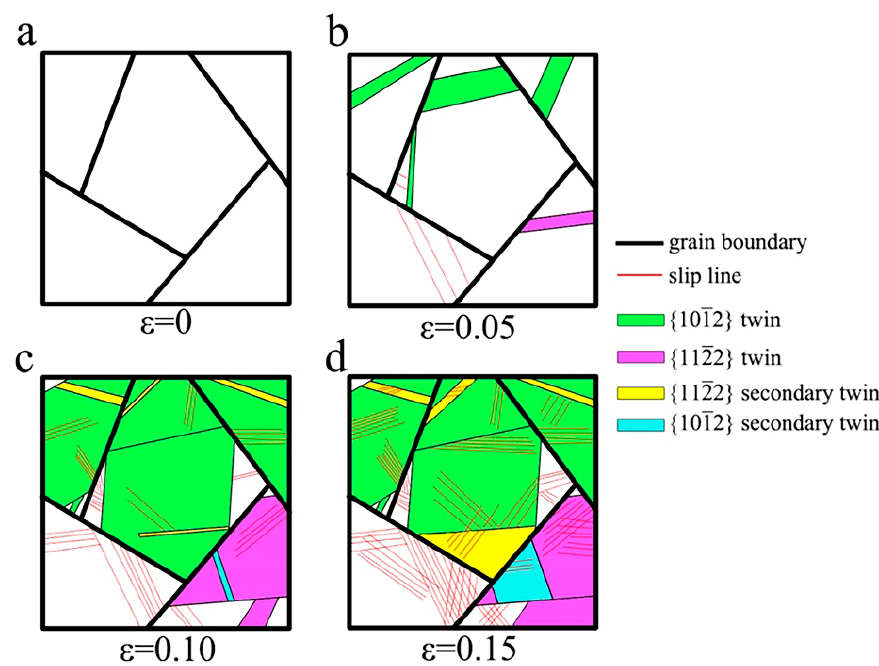
Figure 8. A schematic diagram showing the microstructural evolution of pure Ti under high strain rate compression with strains of ( a ): 0; ( b ): 0.05; ( c ): 0.10; ( d ): 0.15.